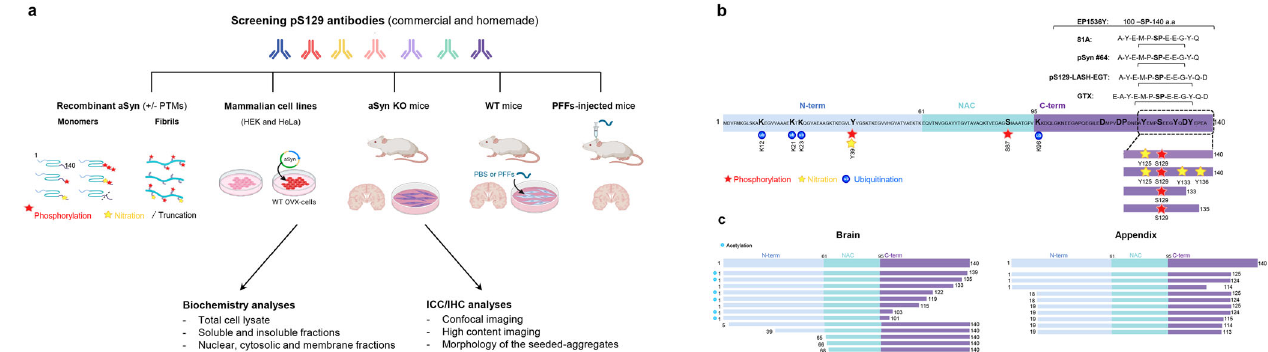
Fig. 1 Assessment of the background and speci fi city of commercial and homemade pS129 antibodies in vitro and in cellular and animal models. a The diagram depicts the work fl ow of our study to assess the background and speci fi city of commercial and homemade pS129 antibodies using recombinant aSyn monomers and fi brils (WT or carrying speci fi c PTMs such as nitration, phosphorylation and/or truncation), mammalian cell lines overexpressing aSyn, aSyn KO primary neurons, WT neurons treated with aSyn PFFs or WT mice injected with aSyn PFFs. The background and speci fi city of the selected pS129 antibodies were evaluated by Western blot analyses or ICC or HTS combined with confocal imaging. Panel A was created using BioRender.com. b The diagram depicts aSyn human sequence, the epitopes of each of the pS129 antibodies (whenever available), and the post-translational modi fi cations that can occur concomitantly in the C-terminal region of aSyn. c The diagram depicts truncations that occurs in the different regions of aSyn in human brains and the